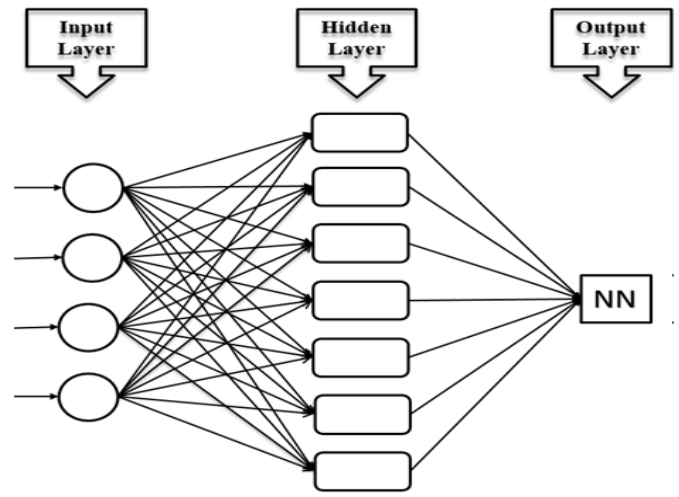
Figure 1. The layered structure of the developed ANN models for NN. Table 13. The input and output parameters for each developed model. Model Table 13. The input and output parameters for each developed model. Model